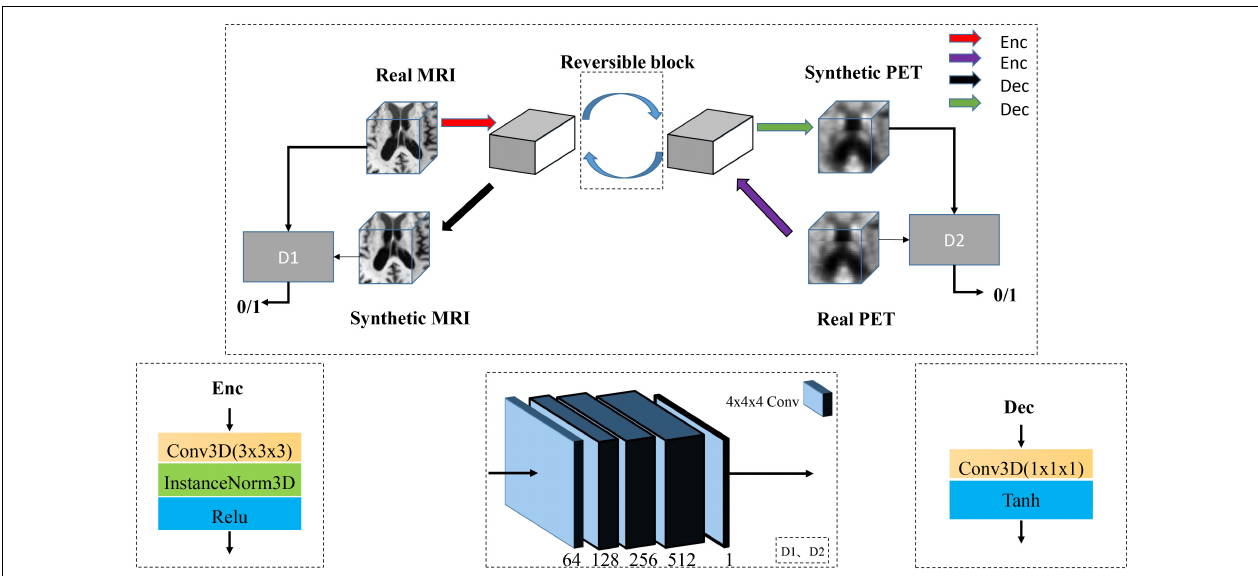
FIGURE 4 | Illustration of our proposed image synthesis method using 3D-RevGAN for learning the mappings between MRI and PET. Encoders Enc (red) and Enc (purple) lift/encode from the image space into the feature spaces. Decoders Dec (black) and Dec (green) project/decode back to the image space. Compared with CycleGAN using two generators, RevGAN only uses one generator to complete the bidirectional mapping from MRI to PET and PET to